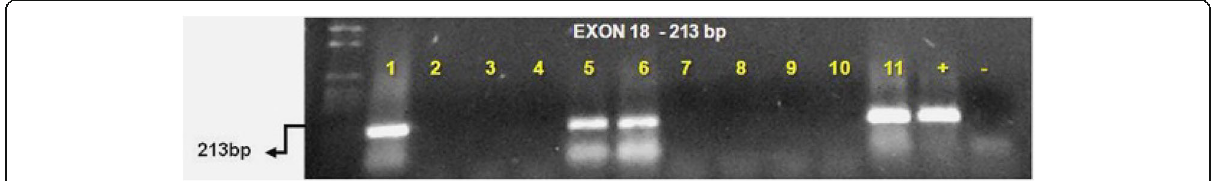
Fig. 4 Agarose (1.5%) gel electrophoresis of 213 bp amplification product exon 18 PDGFRA gene in GIST